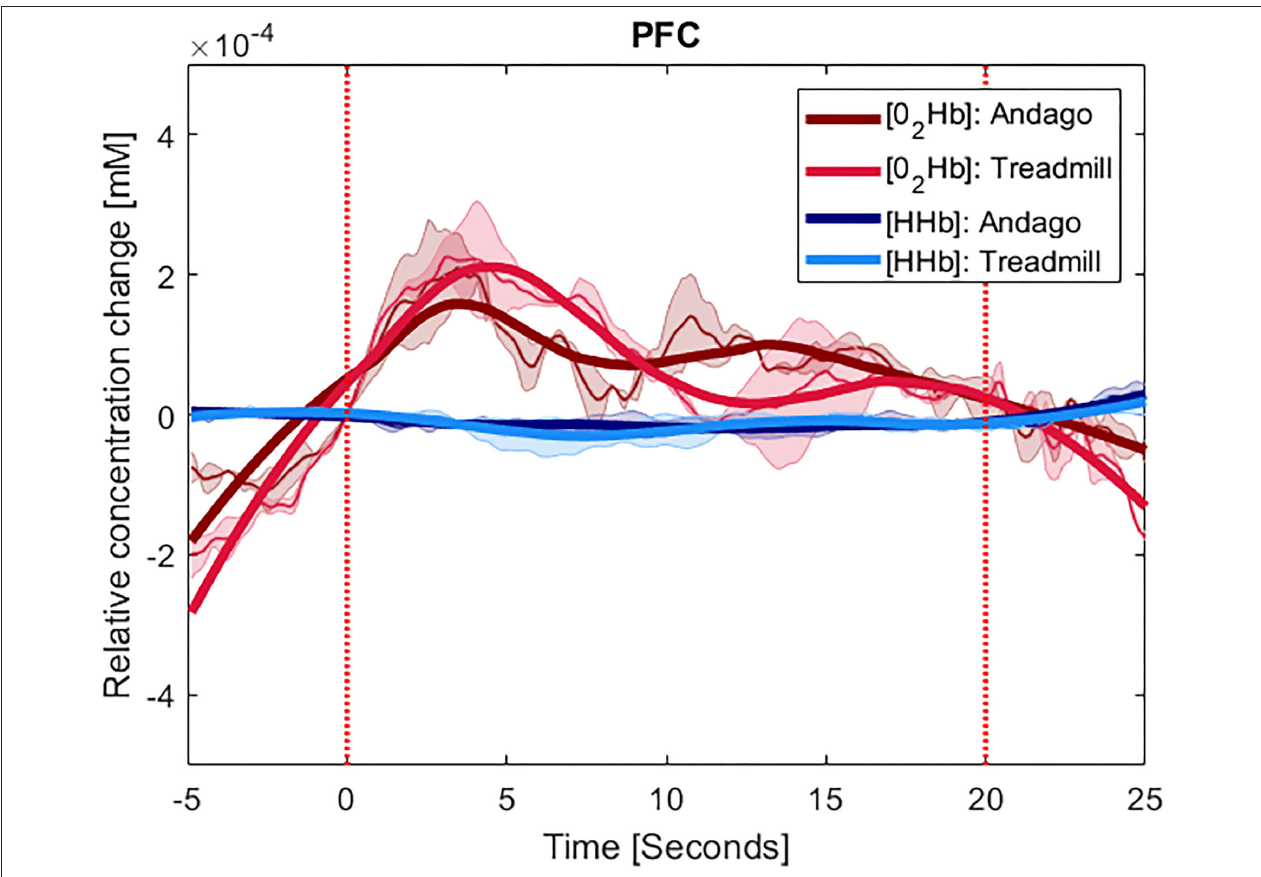
FIGURE 3 | Averaged time-series for group 1 for PFC. The y-axis shows the concentration changes in millimoles per liter (mM) of O 2 Hb in red and HHb in blue, averaged across the participants with at least one valid channel for the area. Thinner lines represent the averaged curves. The shaded area represents the standard error of the mean. The thick lines represent smoothened concentration changes. The x-axis represents the time of the stimulus (20s) plus the 5s before and 5s after it. The vertical red lines indicate the onset and end of the stimulus. The plots displaying the hemodynamic responses in the PFC were averaged over 3 participants (ID 7, 13, and